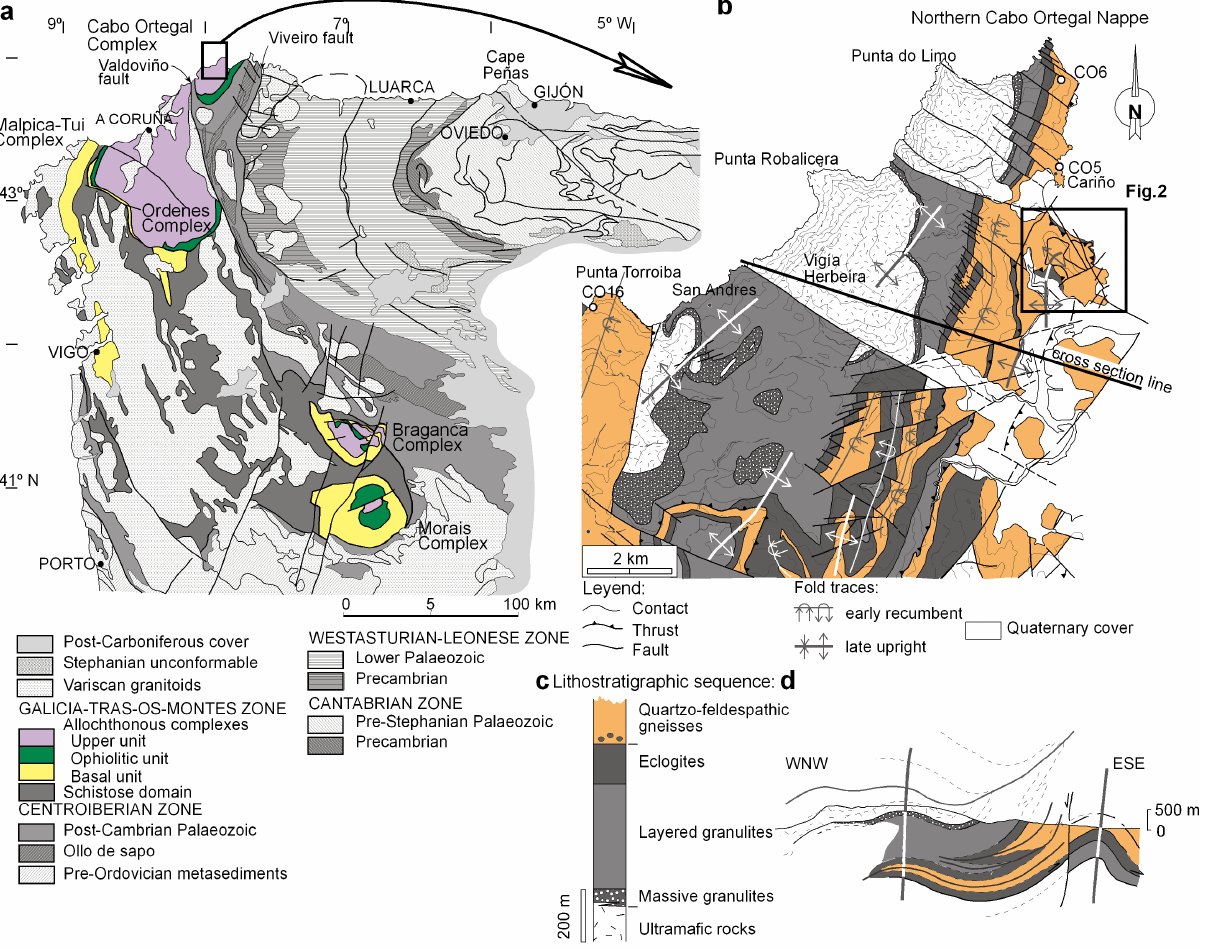
Figure 1. (a) Geological map of the Variscan Belt in N Iberia, highlighting the allochthonous complexes, based on Parga Pondal et al. (1982). (b) Geological map with location of Fig. 2 and the CPOs samples. (c) Lithostratigraphic sequence and (d) cross-section of Cabo Ortegal nappe (after Marcos et al.,